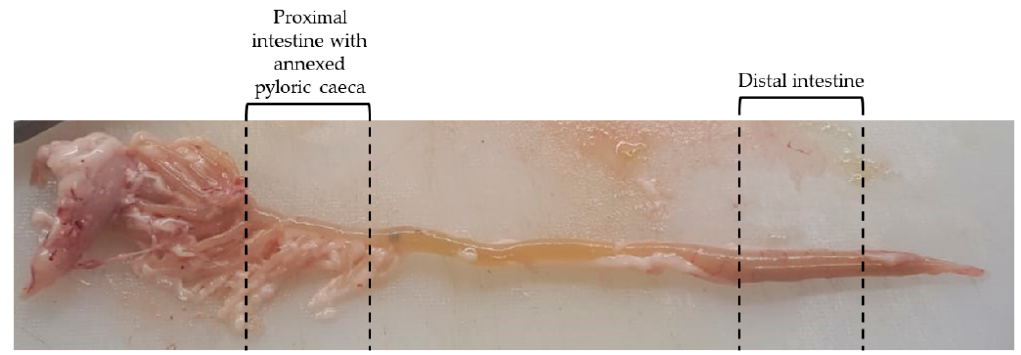
Figure 1. Selected regions of the samples collection.